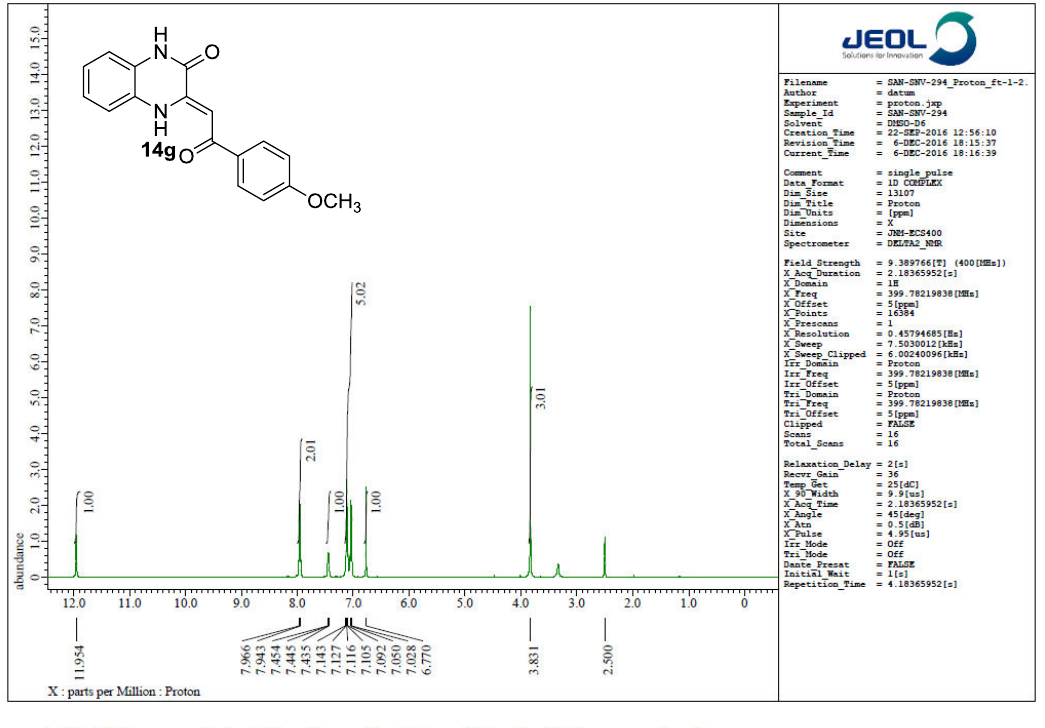
Figure 41 . 1 H NMR Spectra of Compound 14g .